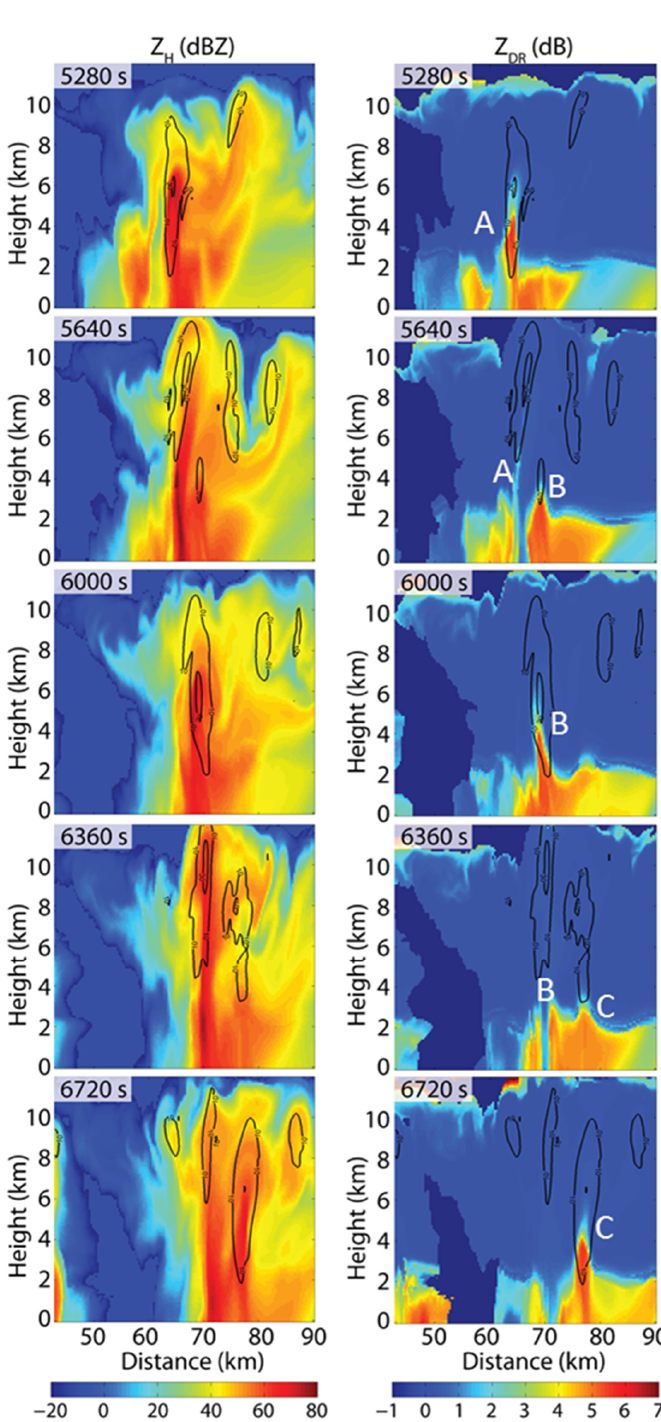
Figure 4. Evolution of vertical cross-sections of Z H ( left panels ) and Z DR ( right panels ) throughout the life cycle of a hailstorm simulated using the Hebrew University cloud model (HUCM). Vertical velocity values of 10 m s − 1 and 30 m s − 1 are contoured in black, and the time within the simulation is in the upper-left corner of each panel. The polarimetric emulator used to produce these images is described in Ryzhkov et al. [15]. White letters “A”, “B”, and “C” highlight three Z DR columns. From Ryzhkov and Zrnic [3]. Used with permission from Springer.